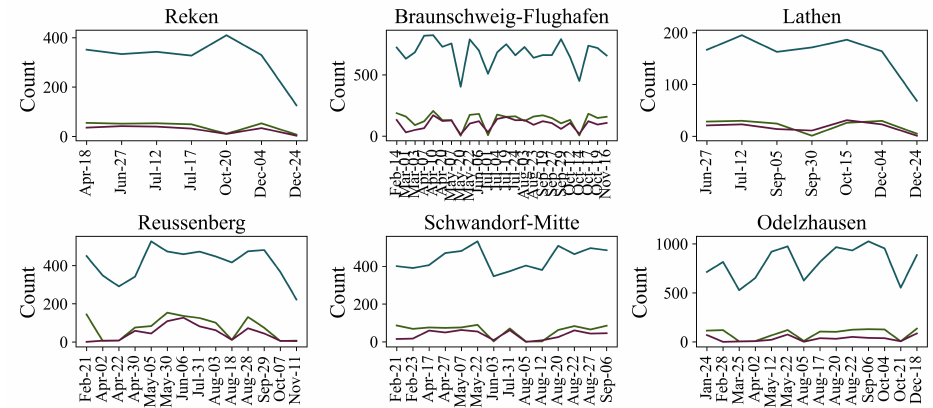
Figure 17. Series of Sentinel-2 truck (red) counts, and station truck (green) and car (turquoise) counts at selected stations in 2018.